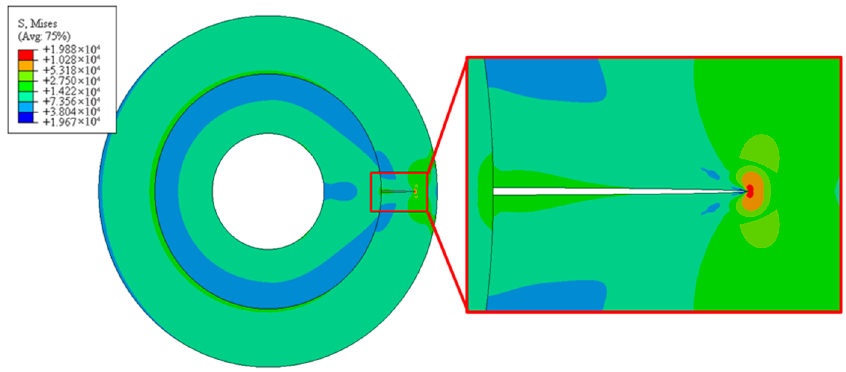
Figure 3. Stress nephogram of a crack ( R 3 = 15 mm, crack depth = 0.6).